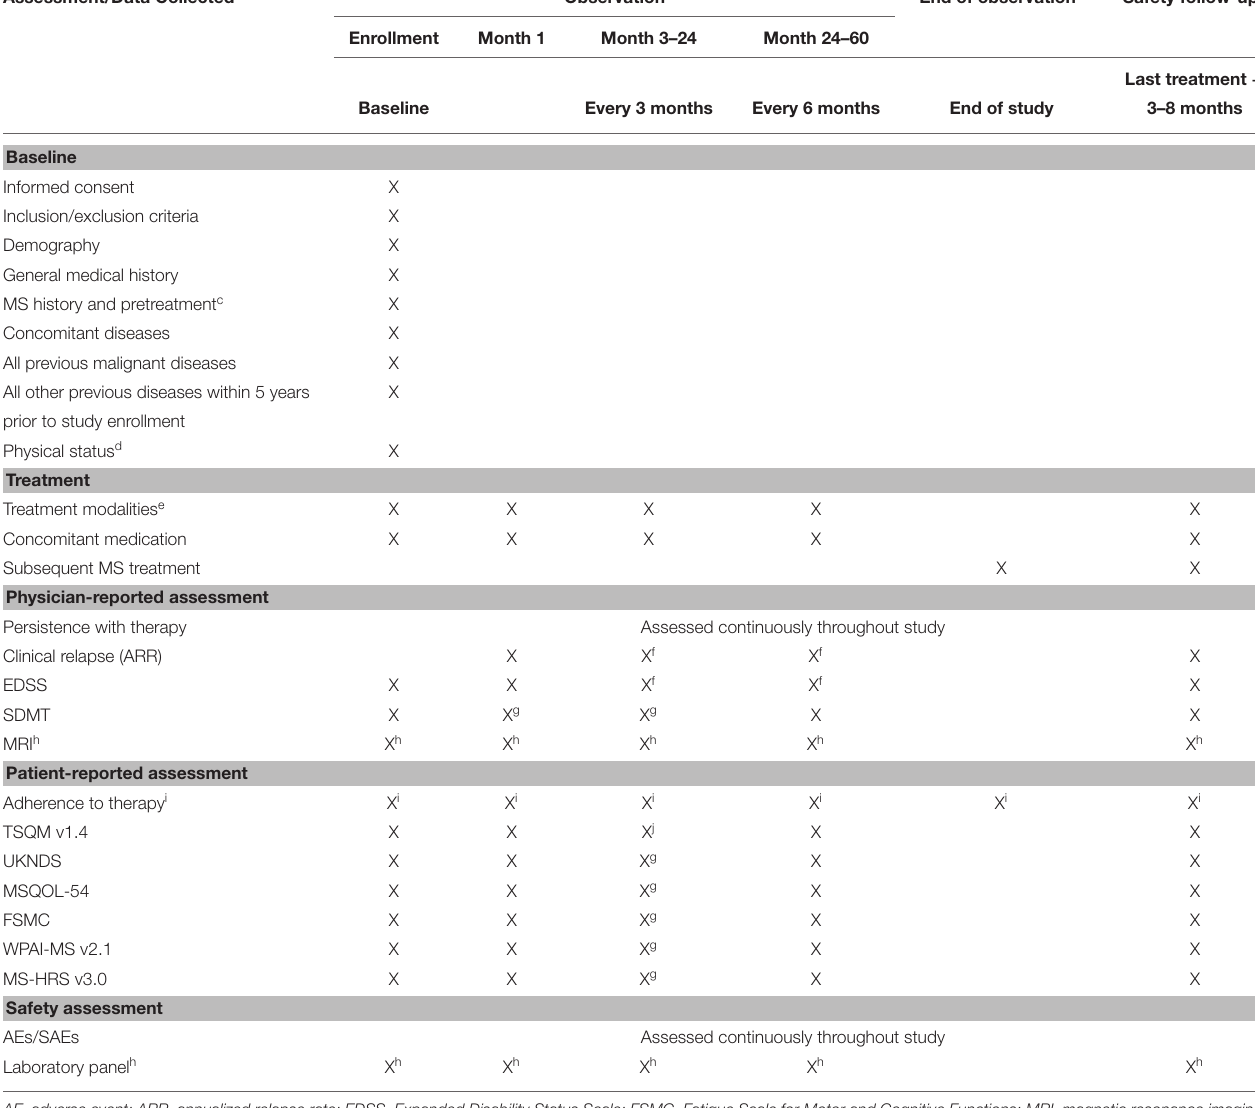
TABLE 2 | Schedule of enrollment, interventions, and assessments. Assessment/Data